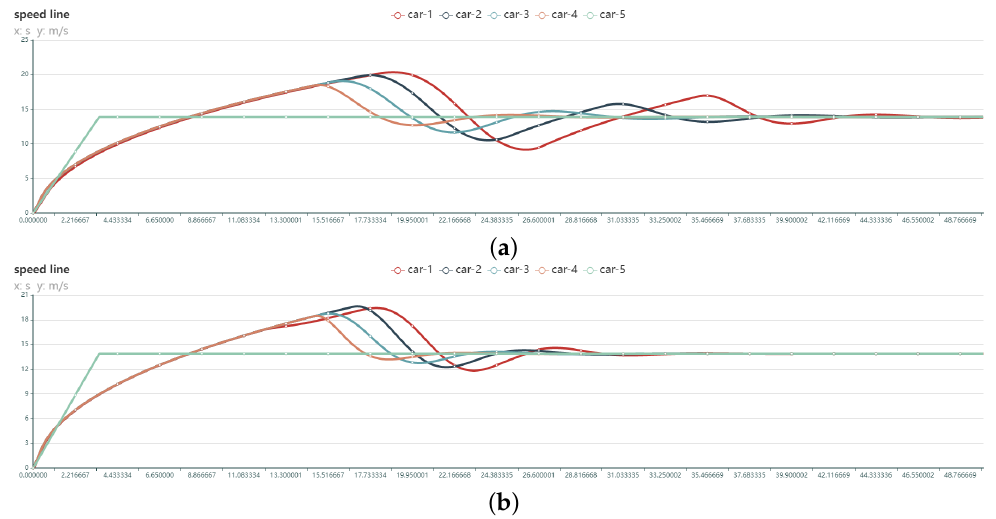
Figure 19. Speed variation curves of 5 vehicles in the convoy using different PID model control (no acceleration control): ( a ) P1 [ K v = 0.2, K g = 0.1 ] ( b ) P2 [ K v = 0.2, K g = 1.0 ] .